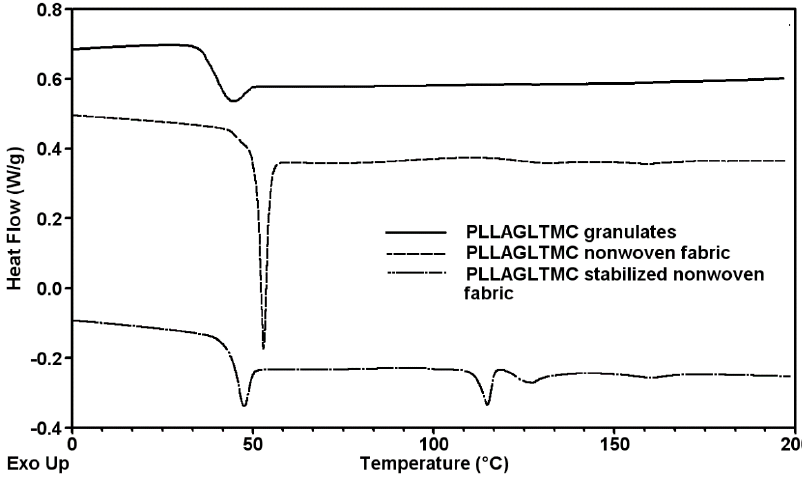
Figure 1. The characteristic temperature determination using differential scanning calorimetry (DSC) analysis recorded during the first heating. Table 1. Characteristic temperatures of the studied materials obtained for differential scanning calorimetry analysis.